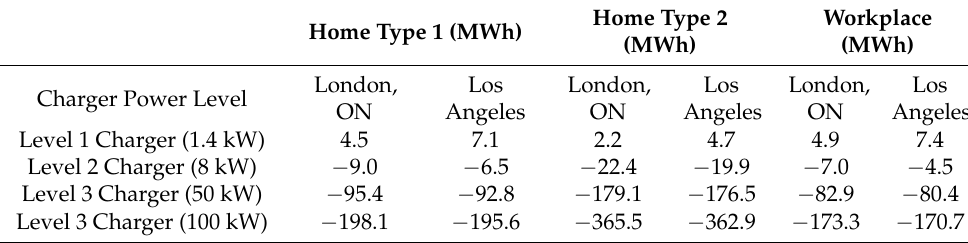
Table 10. Comparison of the annual energy balance (MWh) of a single PV carport and a charging station (charging multiple EVs) between London, ON, and Los Angeles. The comparison accounts for different charger power levels and different charging sites. Positive values represent energy injected into the grid by the PV system, and negative values represent energy drawn from the grid.